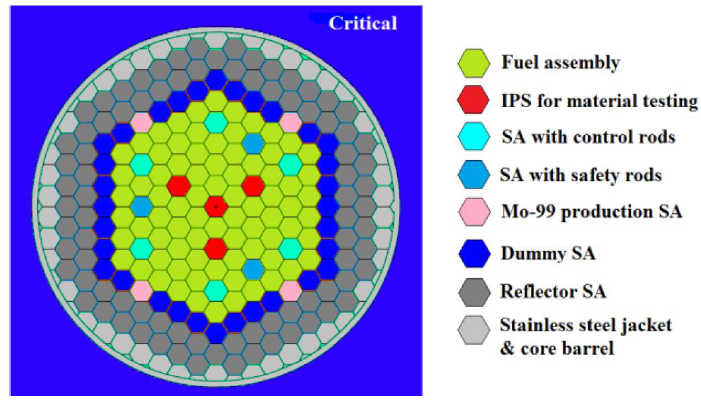
Fig. 1. Critical MYRRHA core layout.